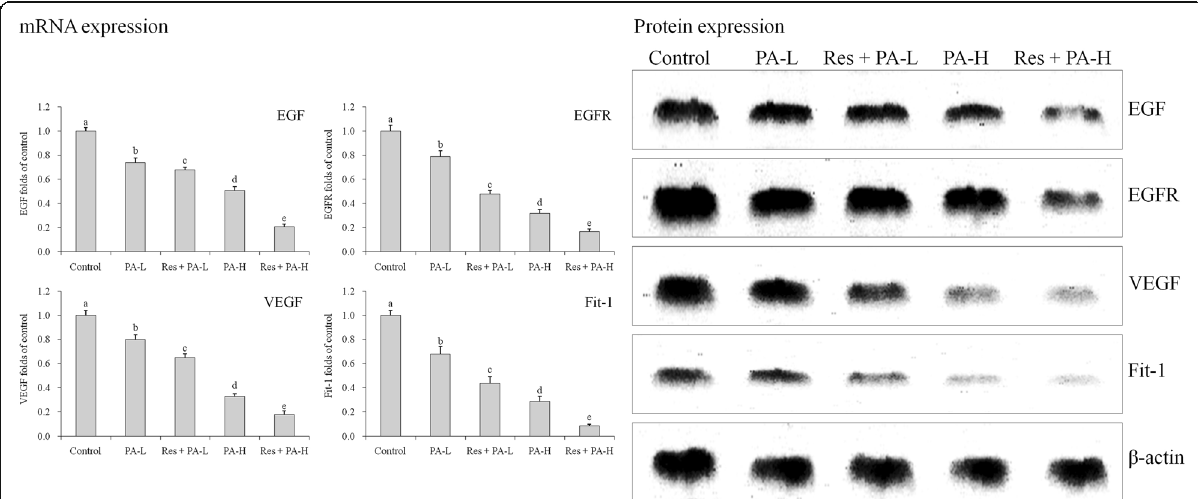
Fig. 12 The mRNA and protein expression of EGF, EGFR, VEGF and Fit-1 in HepG2 human liver cancer cells. a-e Mean values with different letters over the bars are significantly different ( P < 0.05) according to Dunnett ’ s post-hoc test. PA-L: 5 μ g/mL of paclitaxel; Res + PA-L: 10 μ g/mL of resveratrol +5 μ g/mL of paclitaxel; PA-H: 10 μ g/mL of paclitaxel; Res + PA-H: 10 μ g/mL of resveratrol +10 μ g/mL of